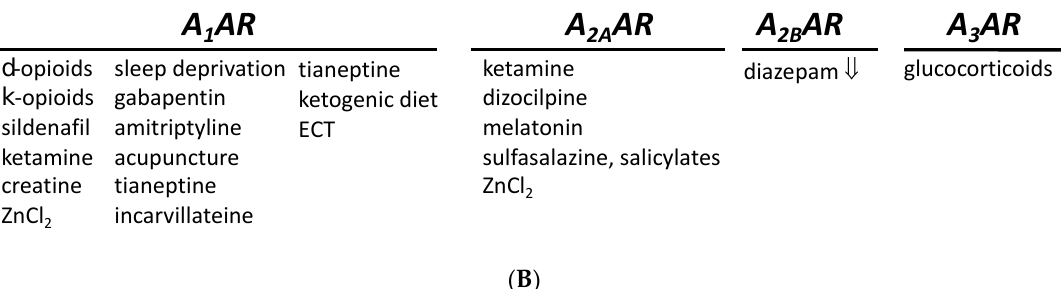
Figure 1. ( A ) Adenosinergic pathways and their putative modulators among non-AR drugs. These interactions have been found in model systems in vitro or in vivo and do not necessarily imply that a compound achieves the indicated effect when administered in humans. Intracellular processes resulting in elevated adenosine concentrations are shown. The A 2B AR (not shown) activates G s protein and has a low affinity for adenosine. ( B ) Drugs or treatments that influence adenosinergic signaling, including those having an undetermined or unclear mechanism (all are stimulatory, except diazepam). Inhibitory and stimulatory effects on the production of cAMP, mediated by Gi and Gs proteins, are shown. Intracellular adenosine concentrations can also be raised through inhibition of ADK (e.g., by 5-iodotubercidin (5-IT, structure not shown), ABT-702 18 , or A-134974 19 ) or of adenosine deaminases (e.g., by deoxycoformycin, DCF 20 ). Moreover, AICAR inhibits an enzyme that metabolizes AMP by deamination, to indirectly increase intracellular adenosine. Compounds that are reported to influence adenosine signaling, but through undetermined AR subtypes, are not listed here.